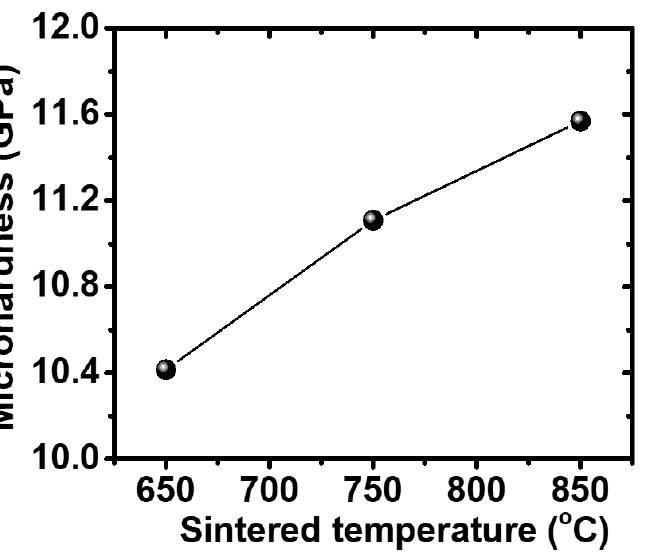
Figure 6. Microhardness value of the Ti 3 Al/Al 2 O 3 composite with selected sintering temperature.